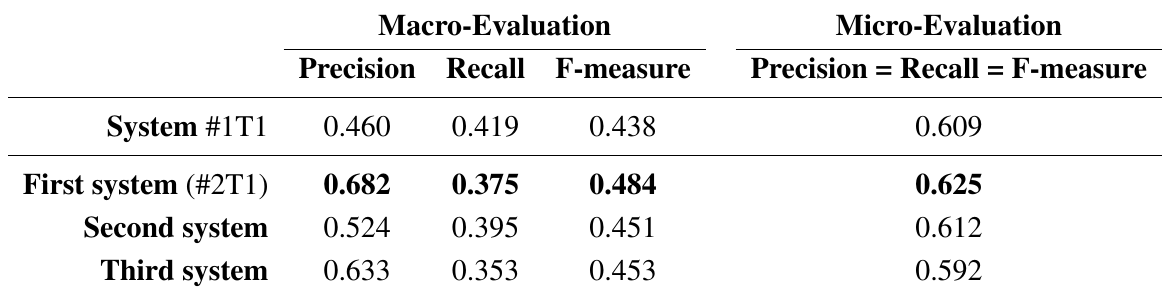
Table 6. Results obtained by system #1T1 on test corpus on task